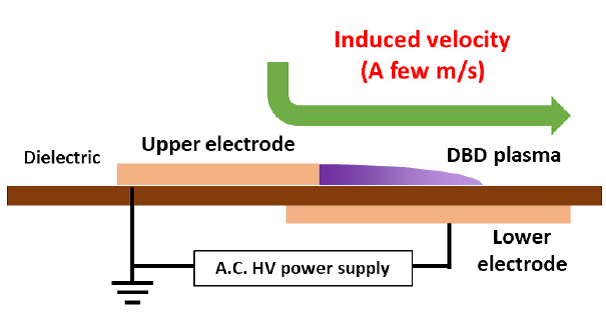
Figure 1. Schematic of a DBD-PA.